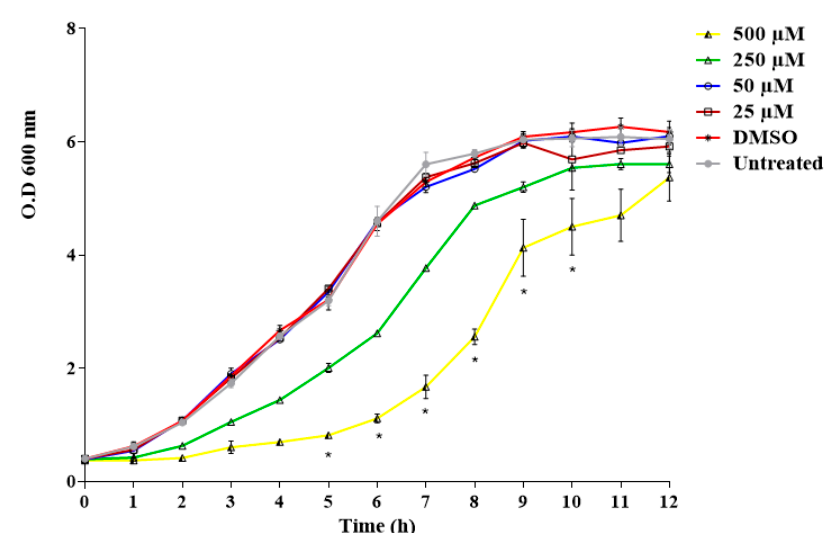
Figure 1. Candida albicans ATCC 90028 growth curve in the presence of 0 µ M, 25 µ M, 50 µ M, 250 µ M, and 500 µ M of limonene. Culture growth was monitored hourly, through OD 600 readings. Measurements were performed in triplicate, and the graph shows the average values and their respective standard deviations. * p < 0.05 compared with the control group (untreated; ANOVA with post-hoc Tukey’s test).